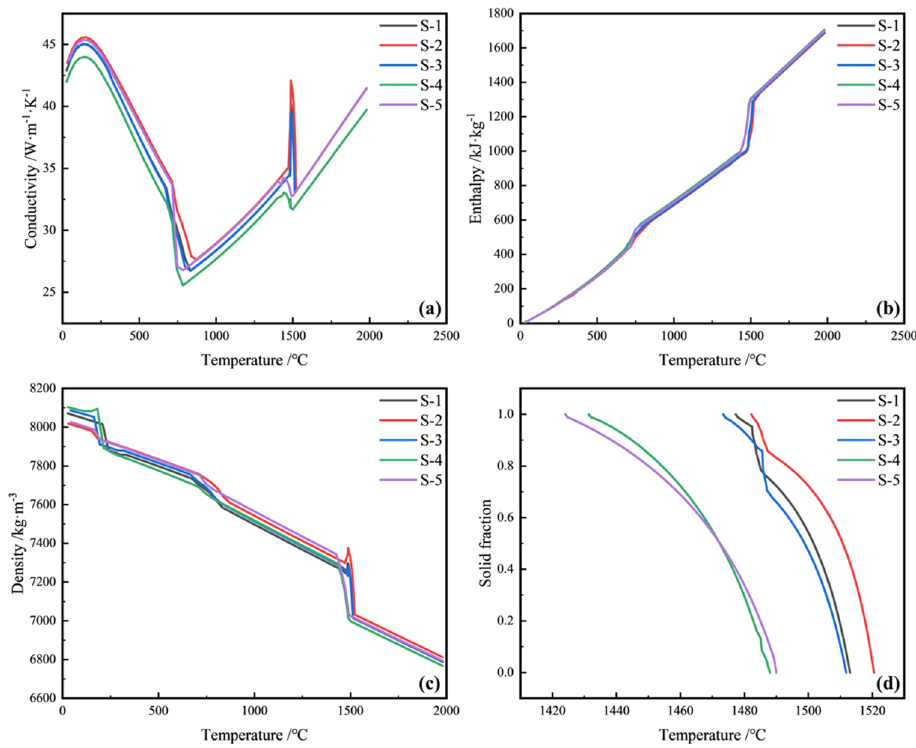
Figure 1. Information about geometric model.